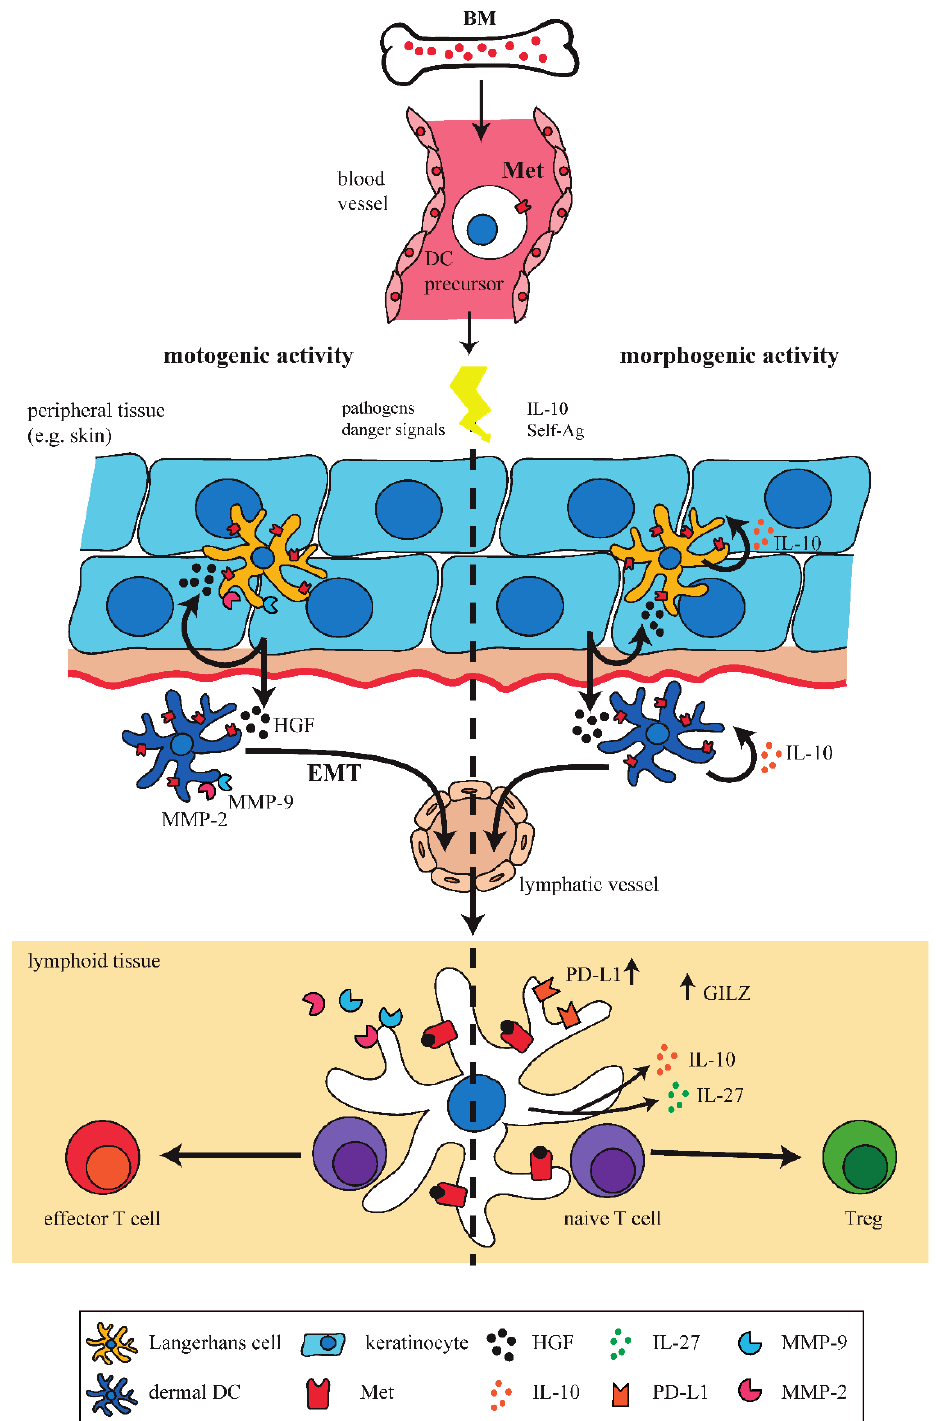
Figure 1. Hepatocyte growth factor (HGF)/Met-signaling in dendritic cells (DCs). Schematic representation of the motogenic and morphogenic activities of Met-signaling on DCs in peripheral and lymphoid tissues. DC precursors originating from hematopoietic stem cells (HSC) in bone marrow (BM) migrate towards peripheral tissues such as the